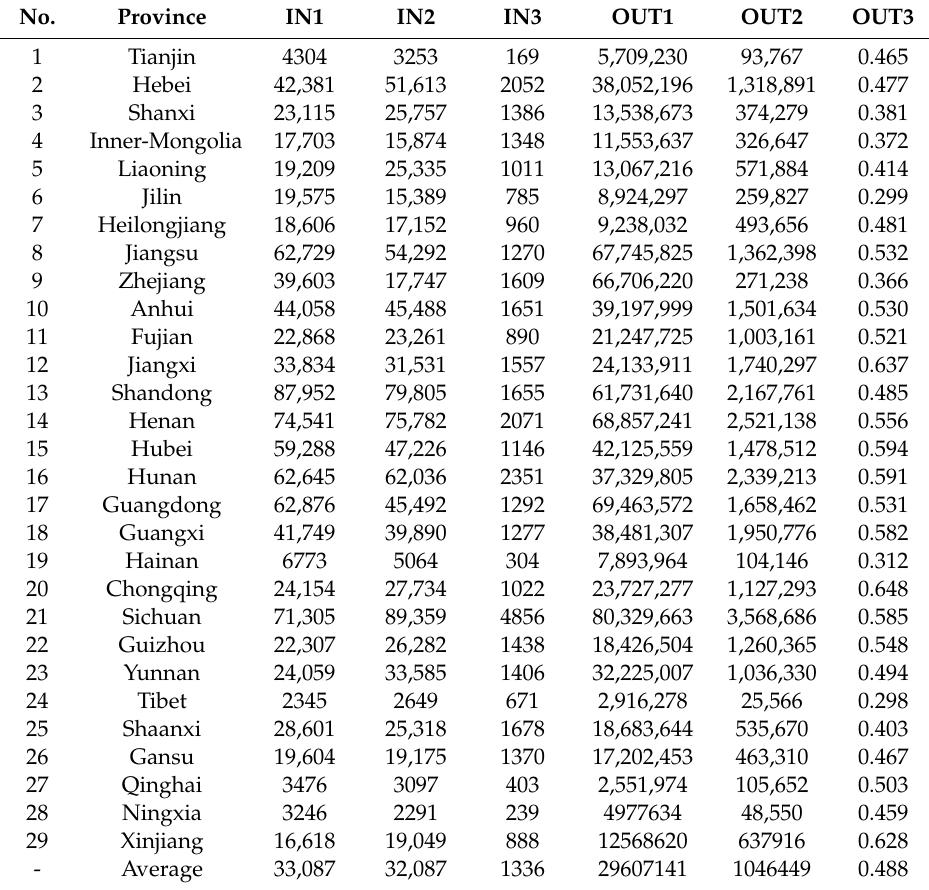
Table 1. Average of Input and Output Variables by Provinces